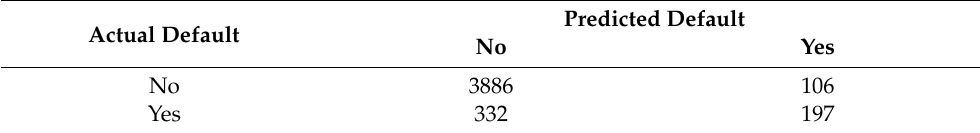
Table 11. Confusion matrix with the CART model.